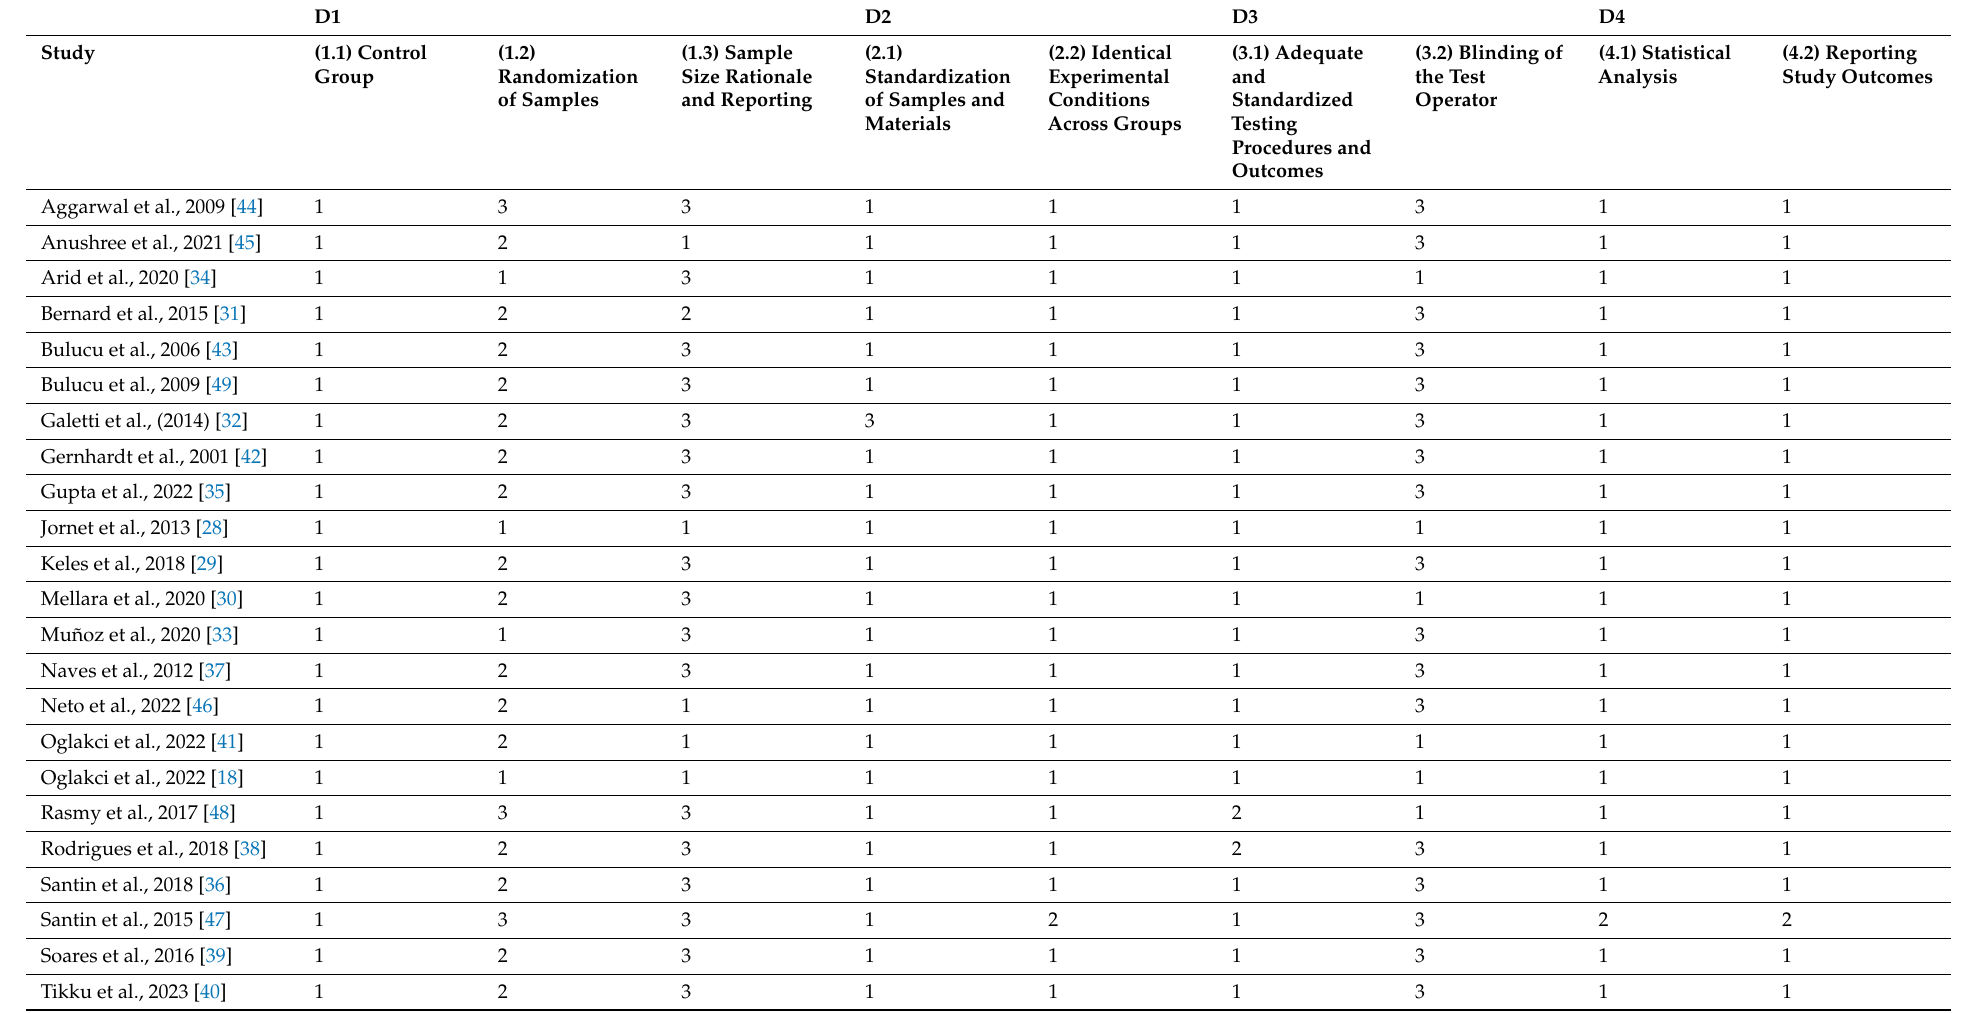
Table A2. Results of the risk of bias assessment. Each RoBDEMAT signaling question in the four domains, D1, D2, D3, and D4, was answered as